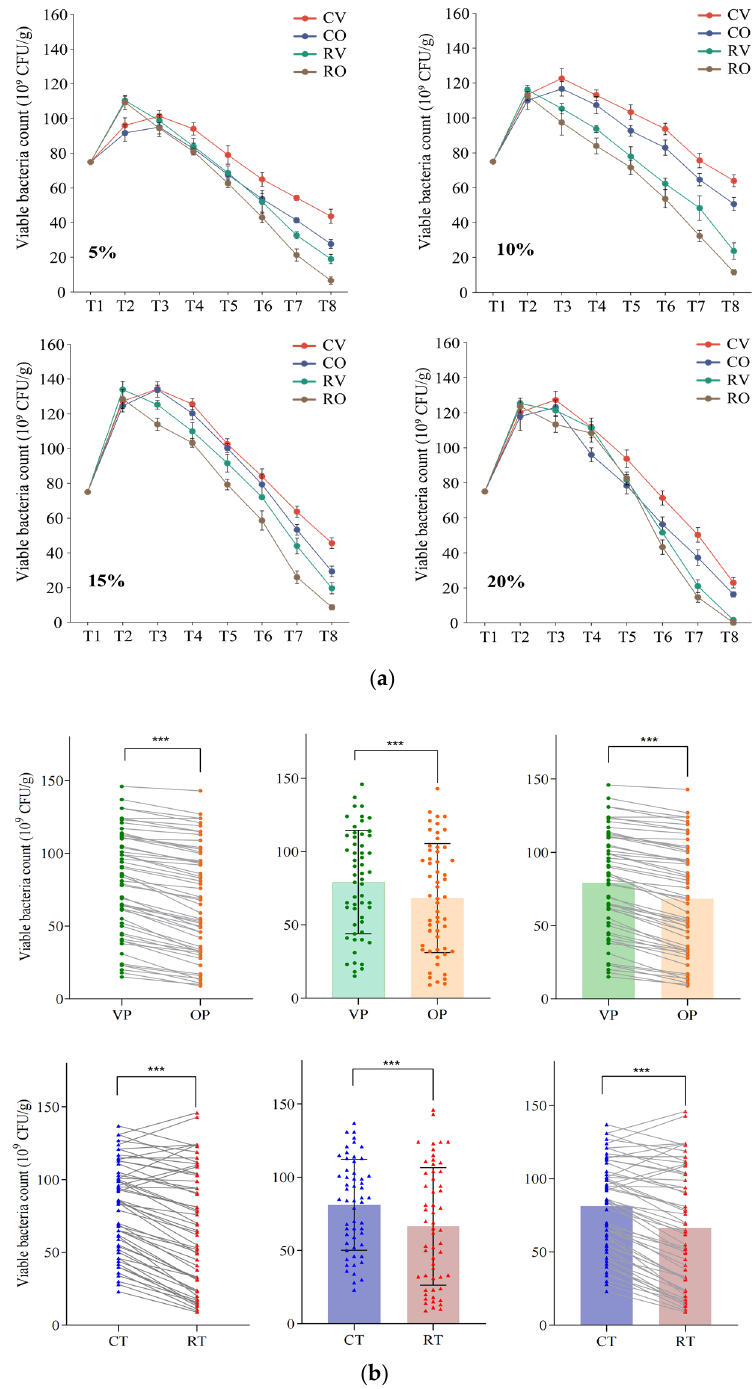
Figure 5. Changes in viable bacterial counts for bacterial agents under different storage conditions.